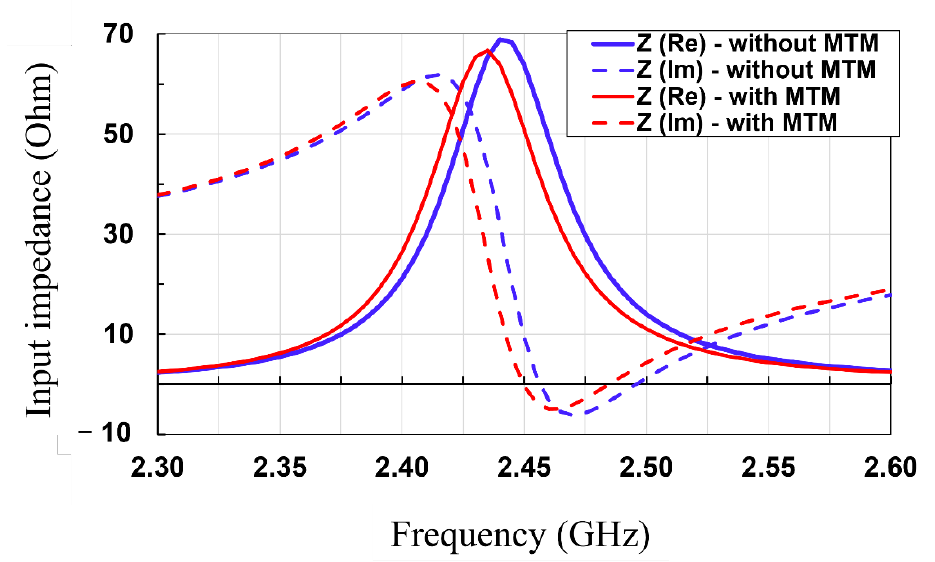
Figure 9. Simulated input impedance of the patch antenna without and with MTM superstrate.